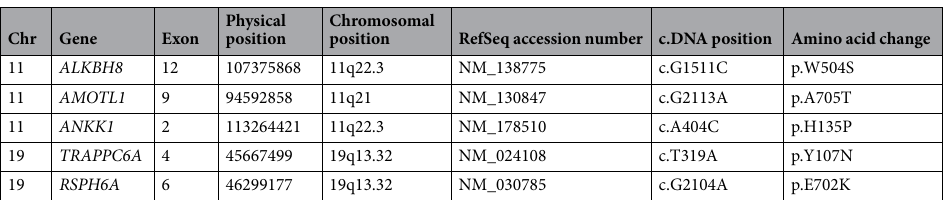
Table 2. Candidate genes resulting from the WES analysis. The chromosomal location, position and accession number of each gene is provided. The position of the mutation in the cDNA and protein sequence is also